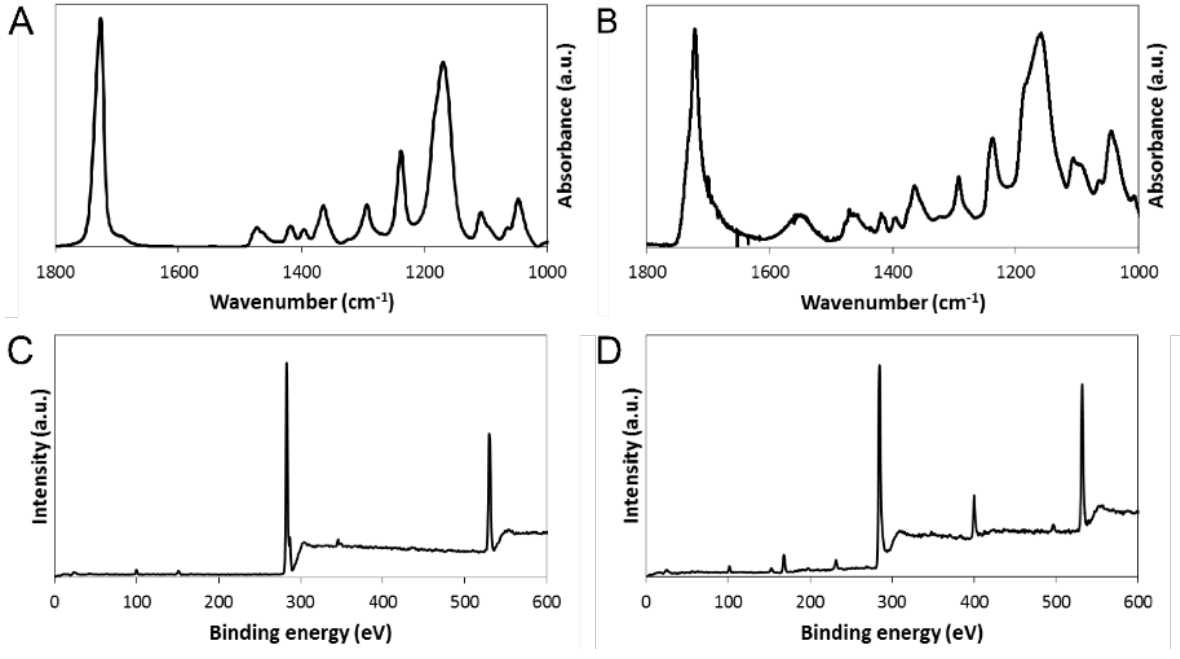
Figure 5. ( A and B ) FTIR spectra of PCL-based tissue scaffolds with aligned pores: ( A ) non-electroactive scaffolds, ( B ) electroactive scaffolds. Peaks observed at ca. 1543 and ca . 1480 cm −1 are characteristic of the antisymmetric and symmetric ring stretching modes of pyrrole [65,78]. ( C and D ) XPS spectra of PCL-based tissue scaffolds with aligned pores: ( C ) non-electroactive scaffolds, ( D ) electroactive scaffolds. Peaks at ca . 400 eV (N 1s) and ca . 168 eV (S 2p) are characteristic of PPy and PSS, respectively